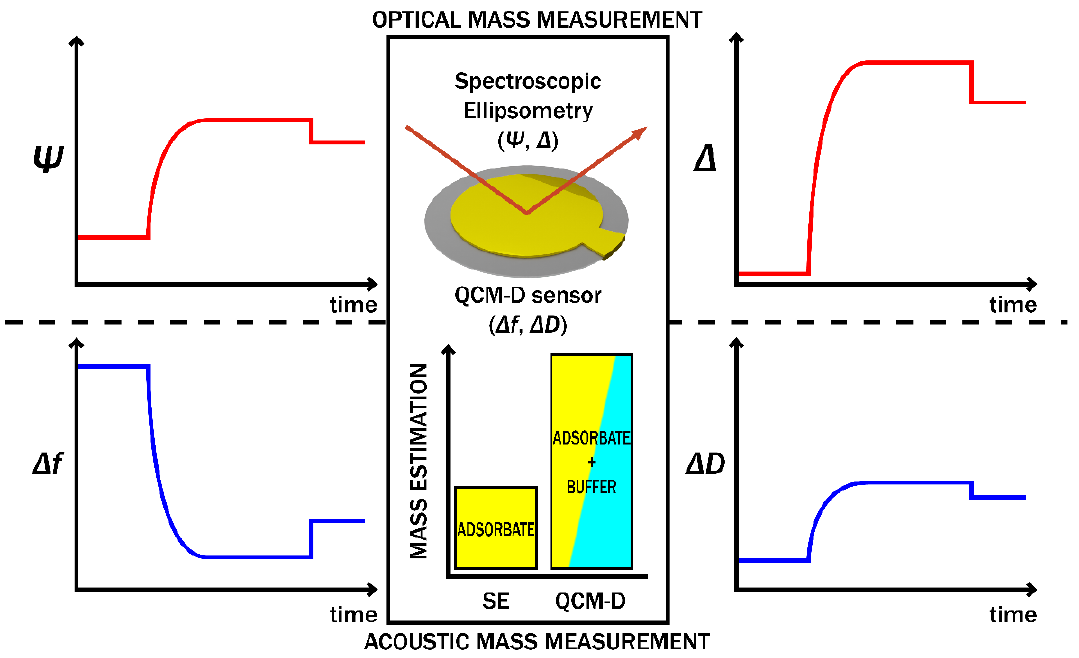
Figure 5. Schematic representation of combined SE/QCM-D technique used for the measurements. Ψ — ellipsometric parameter that corresponds to the light amplitude ratio upon reflection, Δ — ellipsometric parameter that corresponds to light wave phase shift, Δf — time depended change in frequency, ΔD — time depended change in energy dissipation.